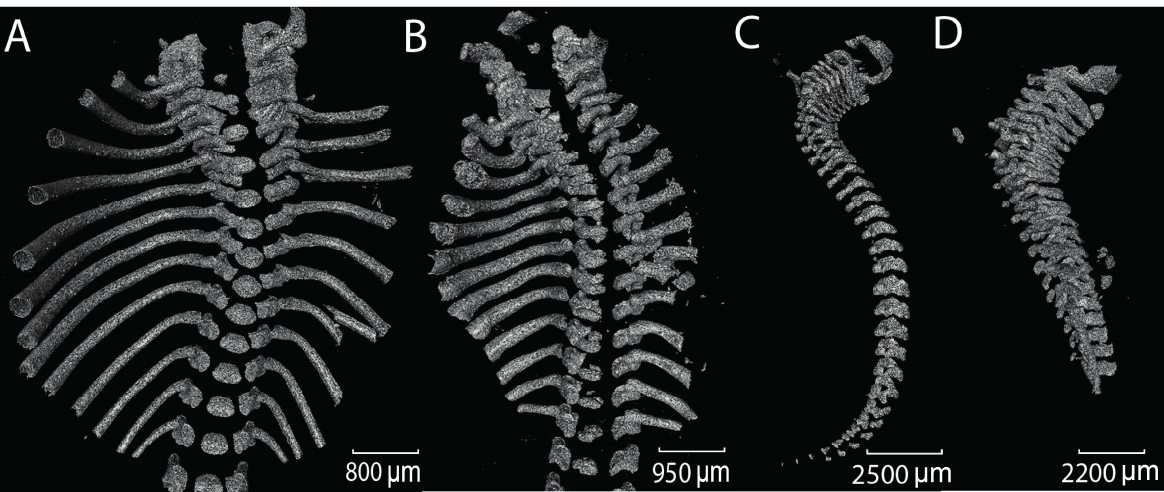
A = 800 µm; scale bar B = 950 µm; scale bar C = 2500 µm; scale bar D = 2200